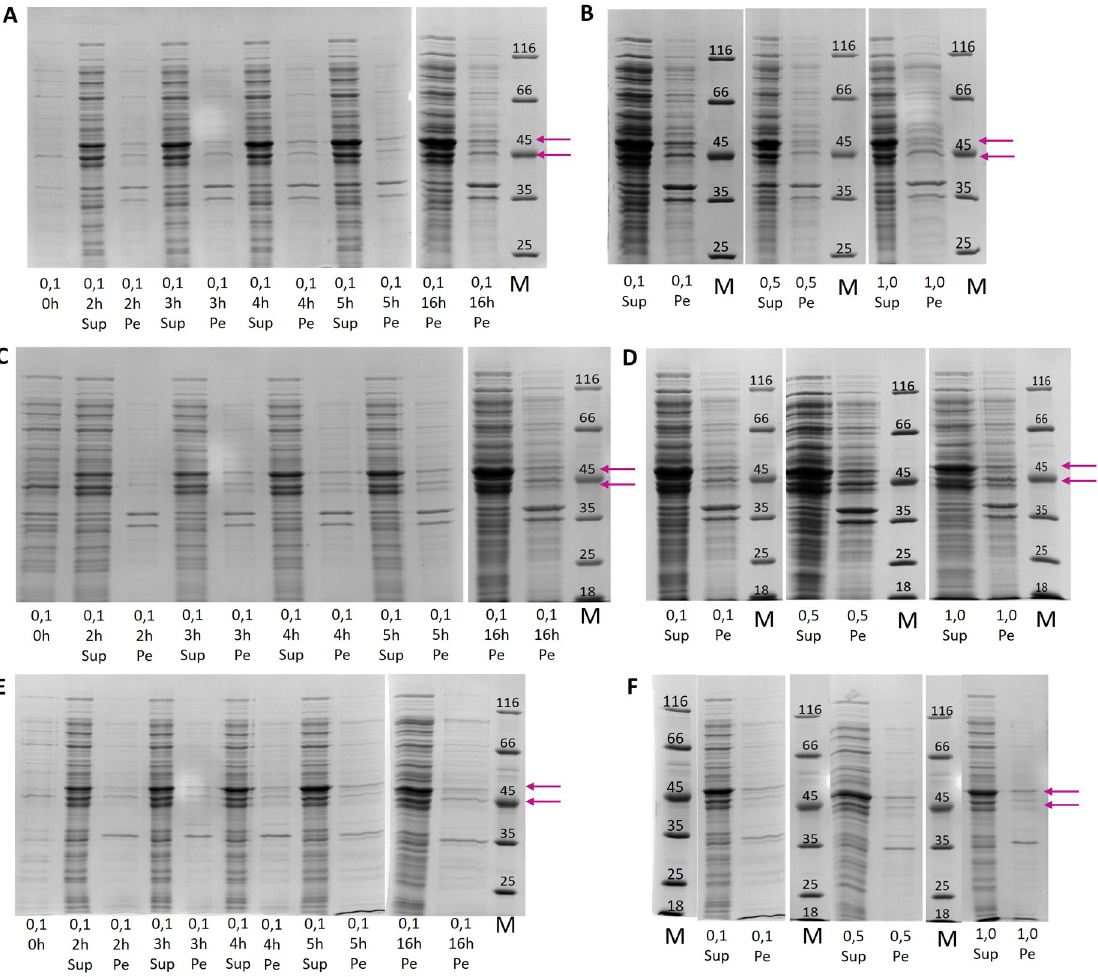
Fig 1. Recombinant expression of RBBP6 p53BD. SDS-PAGE analysis of expression of the RBBP6-p53BD showing soluble "sup" and insoluble "Pe" fractions for (A) : BL21 (DE3) cells over post-induction time of 2 to 16 hours, (B) : BL21 (DE3) cells inducer concentrations from 0.1 mM to 1.0 mM, (C) : NiCo21 (DE3) cells over post-induction time of 2 to 16 hours, (D) : NiCo21 (DE3) cells inducer concentrations from 0.1mM to 1.0mM. (E) : Shuffle 1 T7 express cells over post-induction time of 2 to 16 hours, (F) : Shuffle 1 T7 express inducer concentrations from 0.1 mM to 1.0 mM. The position of overexpressed protein bands is marked with pink arrows. The protein molecular weight marker (Thermo Scientific, 26610) has sizes in kDa, marked on the gel.